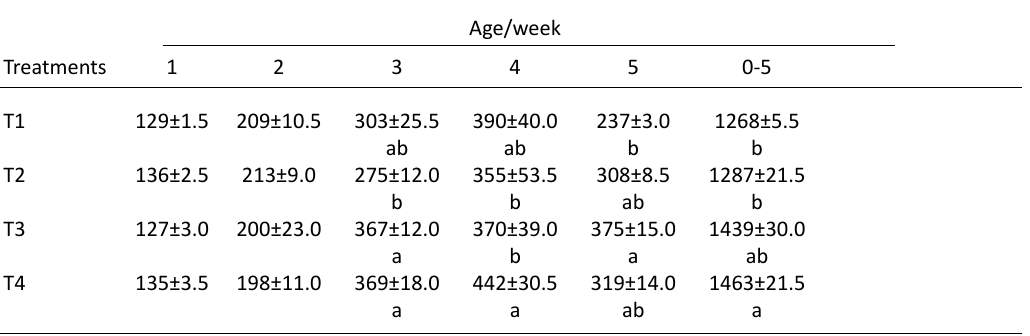
Table 3. Effect of fermented maize by S. cerevisiae in diets on the weight gain (g) of broiler chicks for 5 weeks.